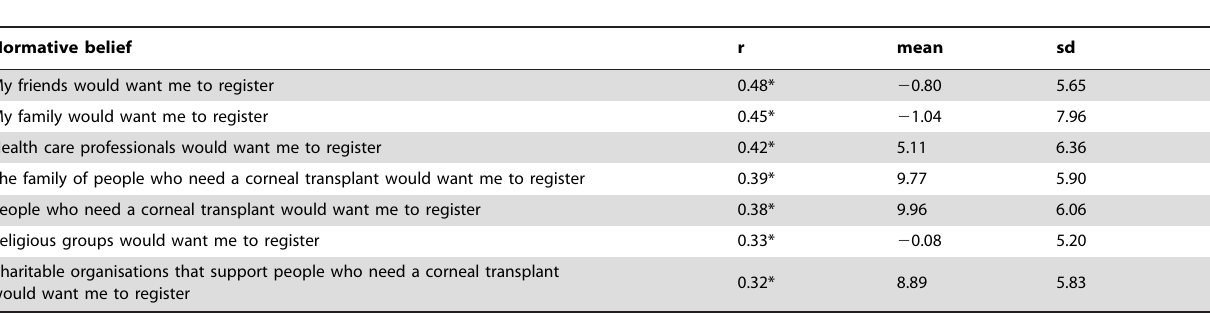
Table 4. Means and standard deviations of normative beliefs and Pearson’s correlations (r) of normative beliefs with intention.